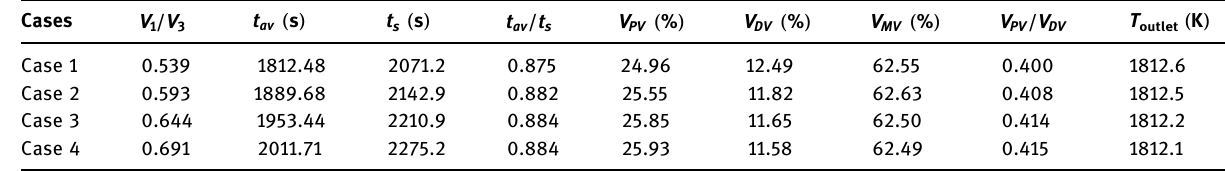
Table 4: Analysis results for the residence time distribution ( RTD ) curve and temperature value for cases Cases